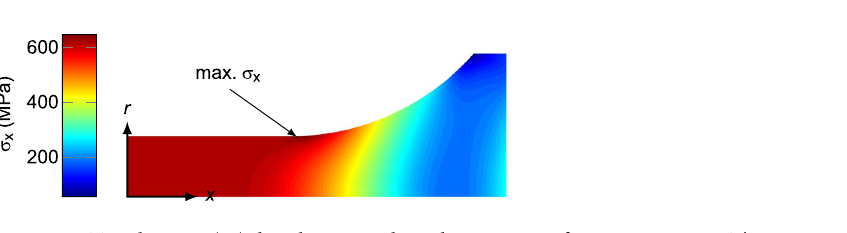
Figure 8. Tensile stress ( σ x ) distribution within a homogenous fatigue test piece – The axisymmetric tensile stress predicted by linear elastic FE modelling in the x and r directions, where x and r are the distance from the sample centre, aligned with, and normal to, the axis of symmetry,